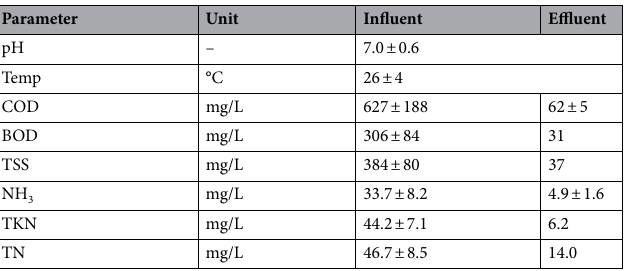
Table 1. Influent, effluent and operational characteristics of HySAF pilot plant in Rishikesh, India used for calibration. Value range provided where present in literature 51 . These input adjustments held true for the validation influents maintaining a < 5.1% deviation across